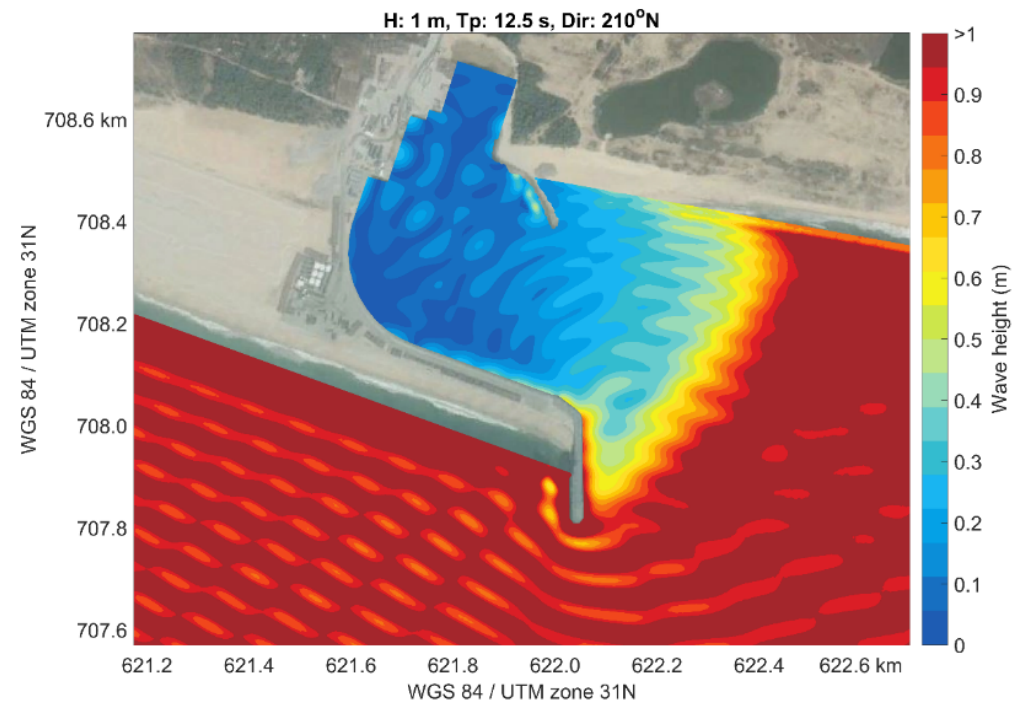
Figure 10. Wave penetration calculation with the H ARES software showing the calculated wave height in colors for the offshore condition of wave height of 1 m, (peak) wave period of 12.5 s and wave direction of 210° N.